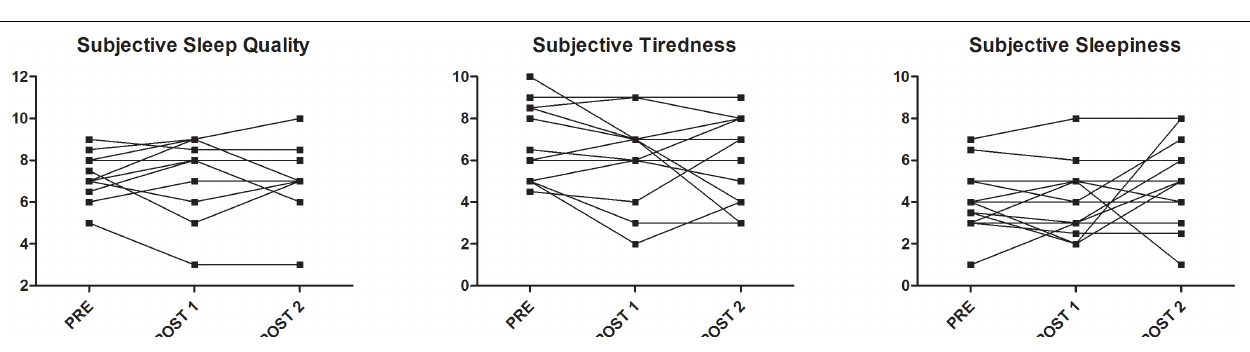
FIGURE 2 | Raw data, with connecting lines, of subjective sleep quality, tiredness, and sleepiness in PRE, POST 1, and POST